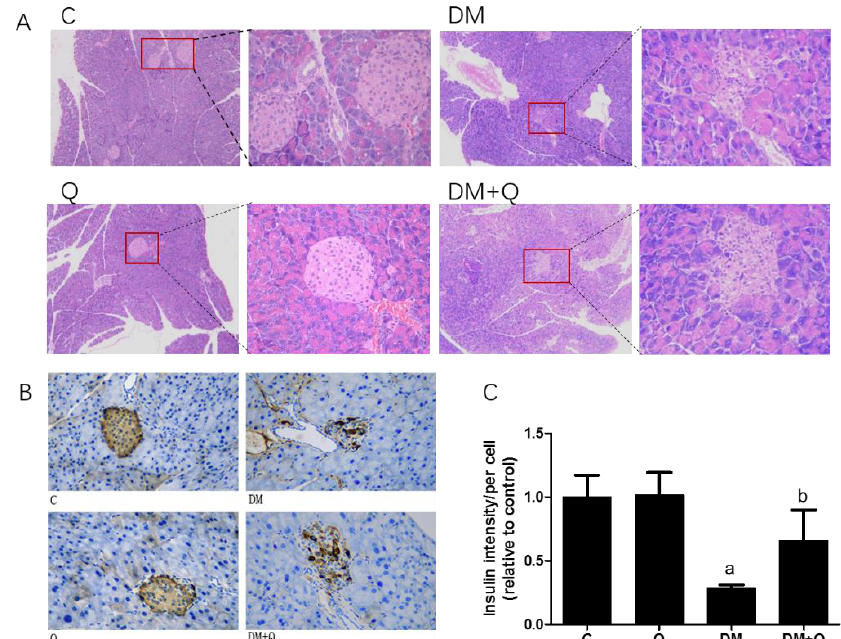
Figure 2. Morphological changes of islets in mice. ( A ). Fixed pancreatic tissue sections of mice stained with hematoxylin and eosin were observed by light microscope (image magnification: 400 × ) ( n = 3); ( B ). Representative images of pancreatic sections immunohistochemically stained for insulin (dark brown) (image magnification: 400 × ) ( n = 3); ( C ). Quantification of insulin level and distribution in islets were detected by immunohistochemically staining in pancreatic tissue ( n = 3); Data were expressed as mean ± SD (a: p < 0.05 vs. C; b: p < 0.05 vs. DM).